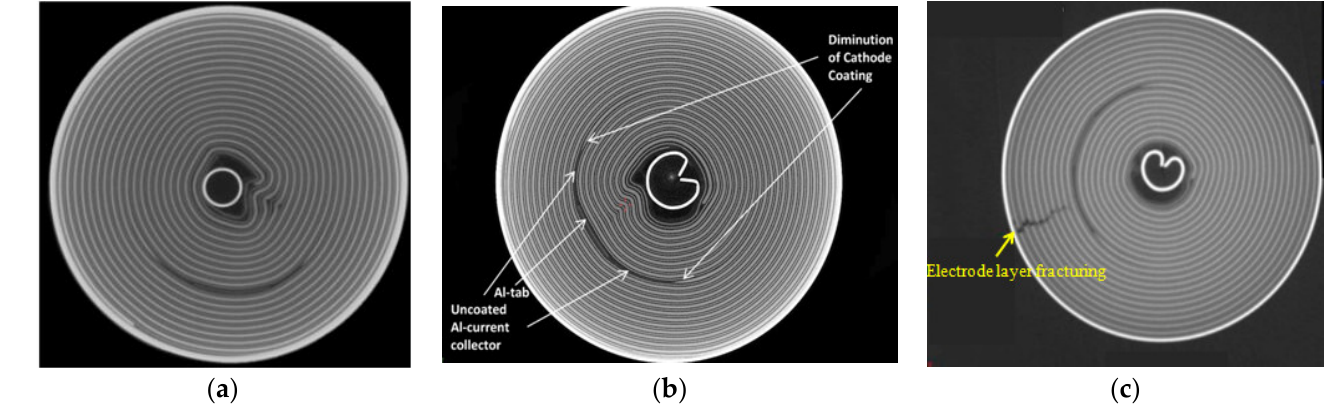
Figure 1. The CT diagram of deformation of jellyroll: ( a , b ) wrinkling of inner jellyroll [3]. Reprinted with permission from Ref. [4]. 2018, Elsevier.; ( c ) fracture of outer jellyroll. Reprinted with permission from Ref. [5]. 2020, Elsevier.